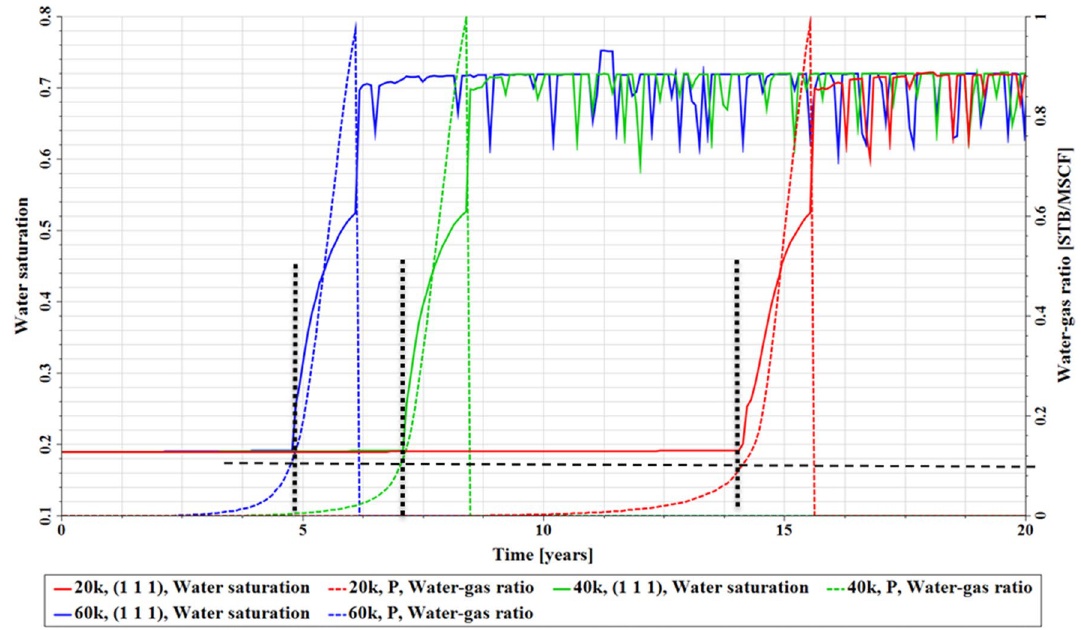
Fig. 36 Water saturation of the top 10% of perforation interval and WGR vs. time at three different production rates, h